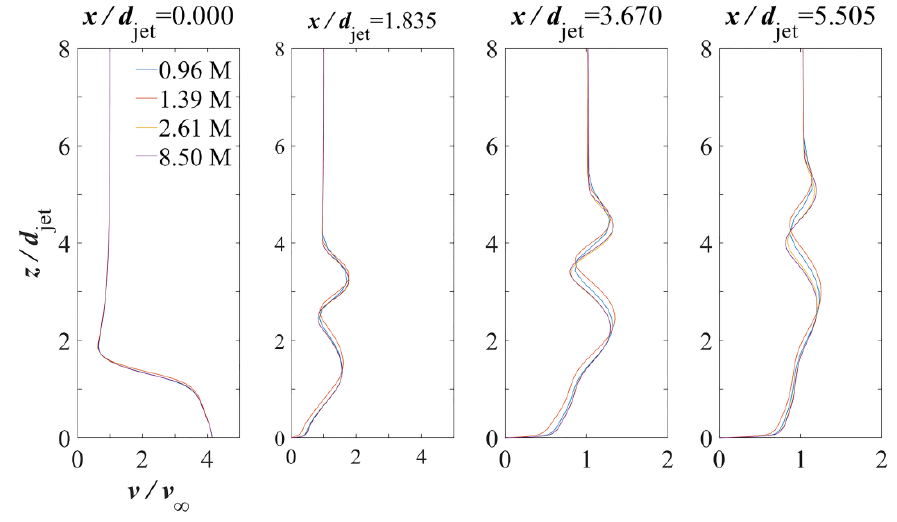
( b ) Figure 3. Mesh sensitivity analysis results of VT ( a ) velocity distribution ( b ) pressure distribution. 3.1.2. Mesh Sensitivity of Cross-Flow The comparison of velocity distribution along the z -direction is shown in Figure 4, in